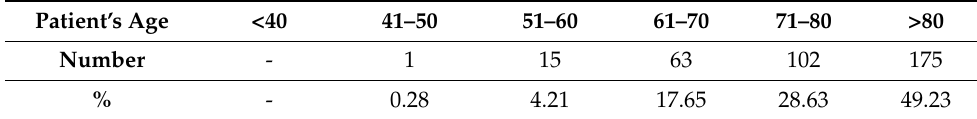
Table 1. Breakdown of batch COV-2 by age bracket.